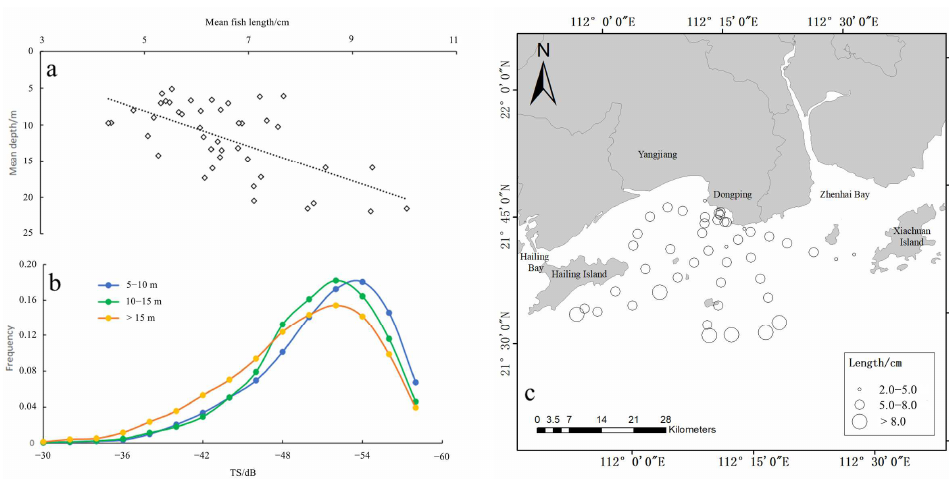
Figure 2. Distribution of Target Strength.